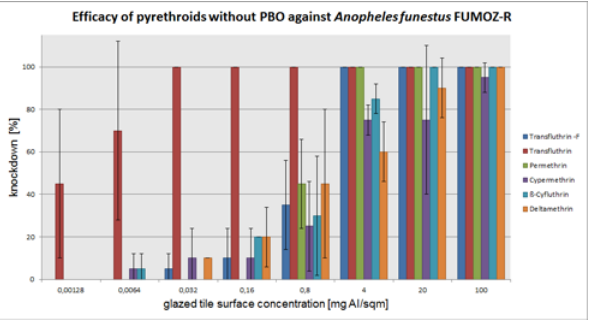
Fig 5. Arithmetic means and standard deviations of the 1 h results of a glazed tile contact bioassay using technical grade pyrethroids without PBO against the metabolic resistant Anopheles funestus FUMOZ-R strain.